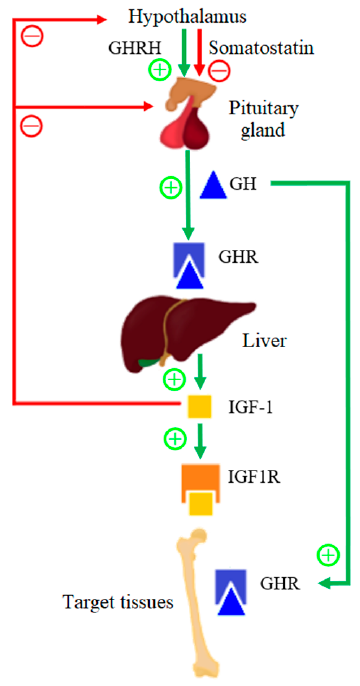
Figure 1. Functional diagram of the GH–IGF-1 axis.